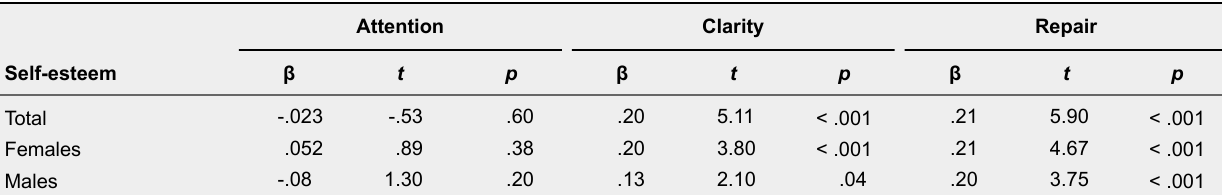
Forecast Self-Esteem With Emotional